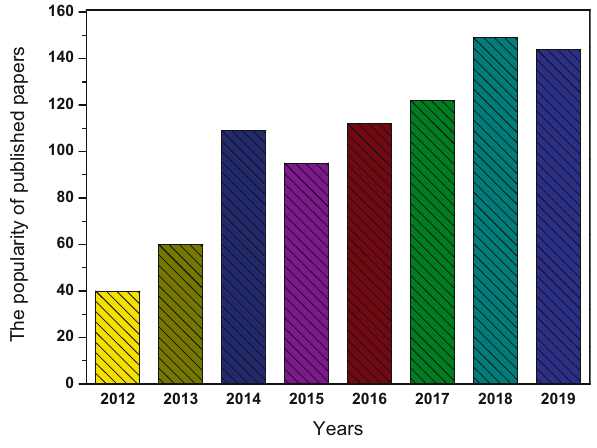
Figure 1: The popularity of using MICNCs for the photodegradation of organic molecules ( keywords: magnetic iron oxide/clays; source: www.scopus.com, 2012 – 2019 )